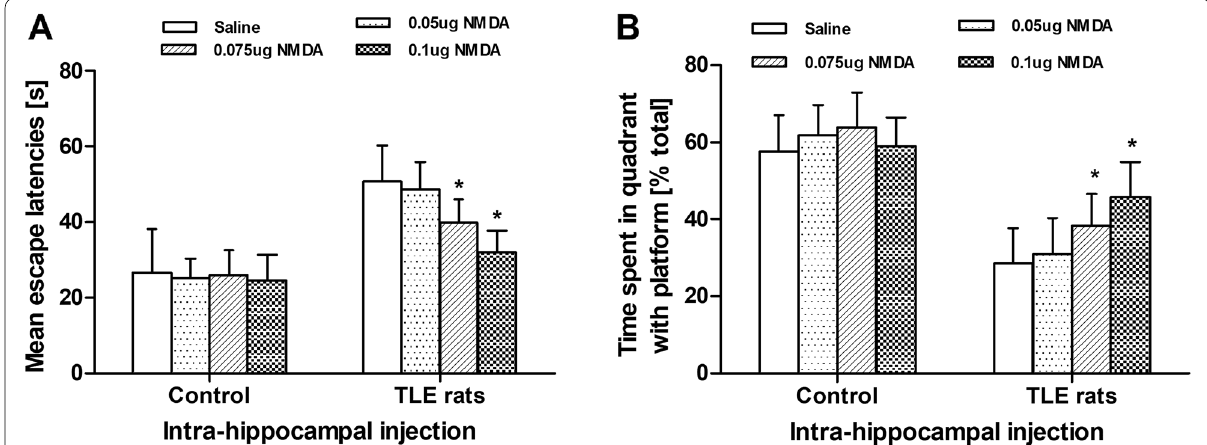
Fig. 3 Bilateral intra-hippocampal injection of NMDA improved cognitive function in TLE rats. a The mean escape latency was decreased after injection of NMDA in TLE rats in water maze. b The time spent in the target quardrant was extended after injection of NMDA in TLE rats in water maze. n 6 for each group; * P < 0.05, vs vehicle, Bonferroni t =